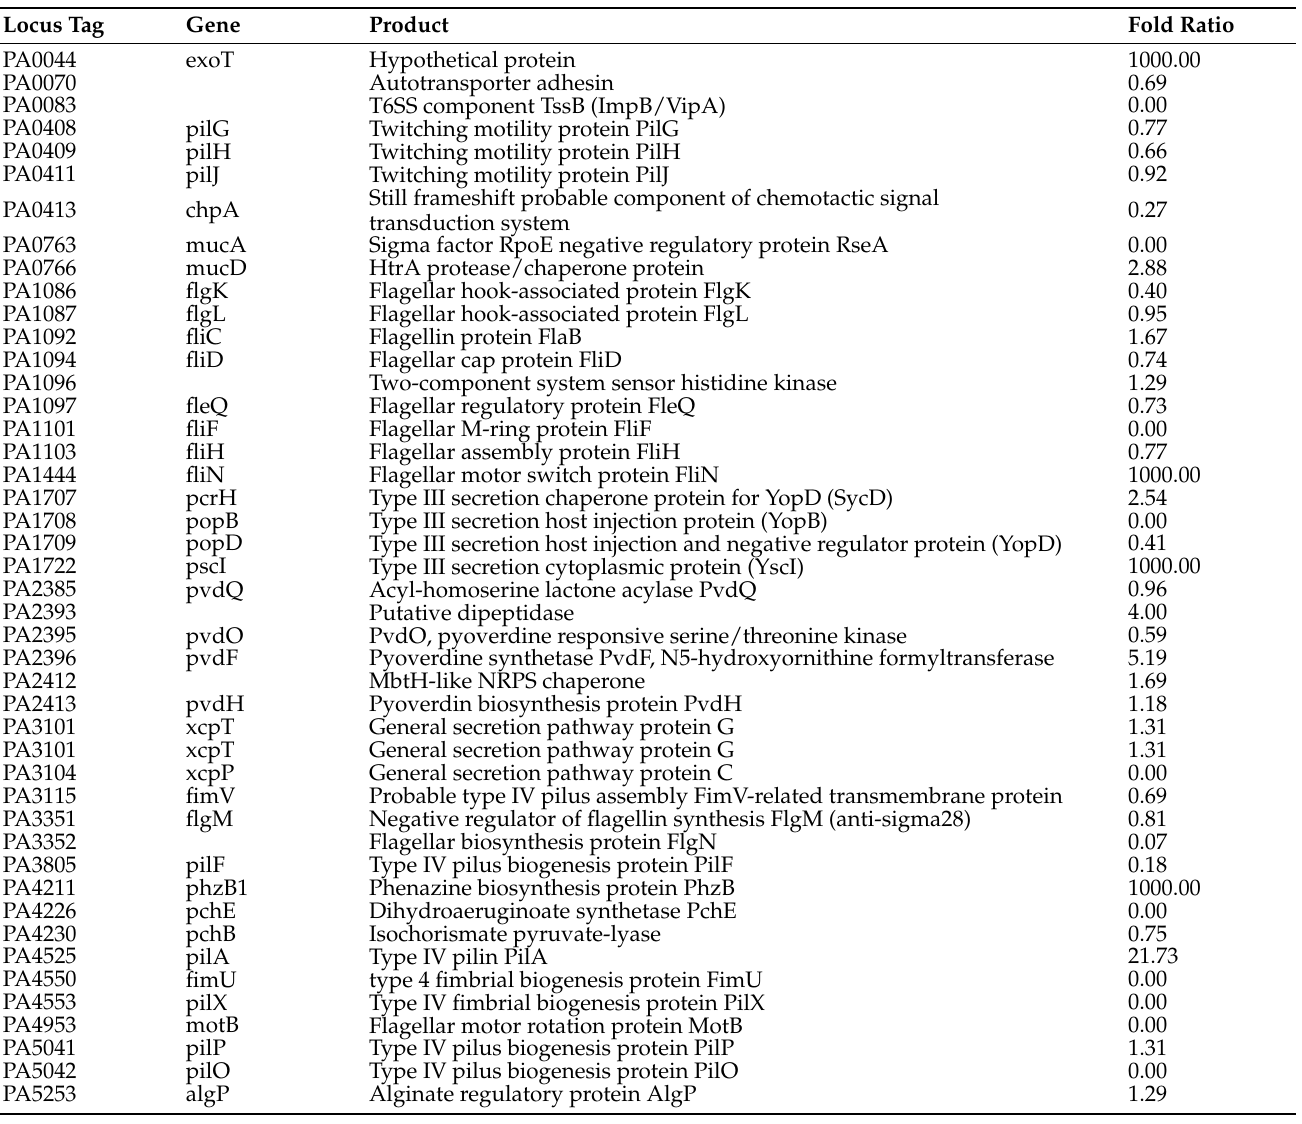
Table 4. Identified proteins associated with virulence of biofilm cells grown with control and antibiotic-impregnated catheters. Locus